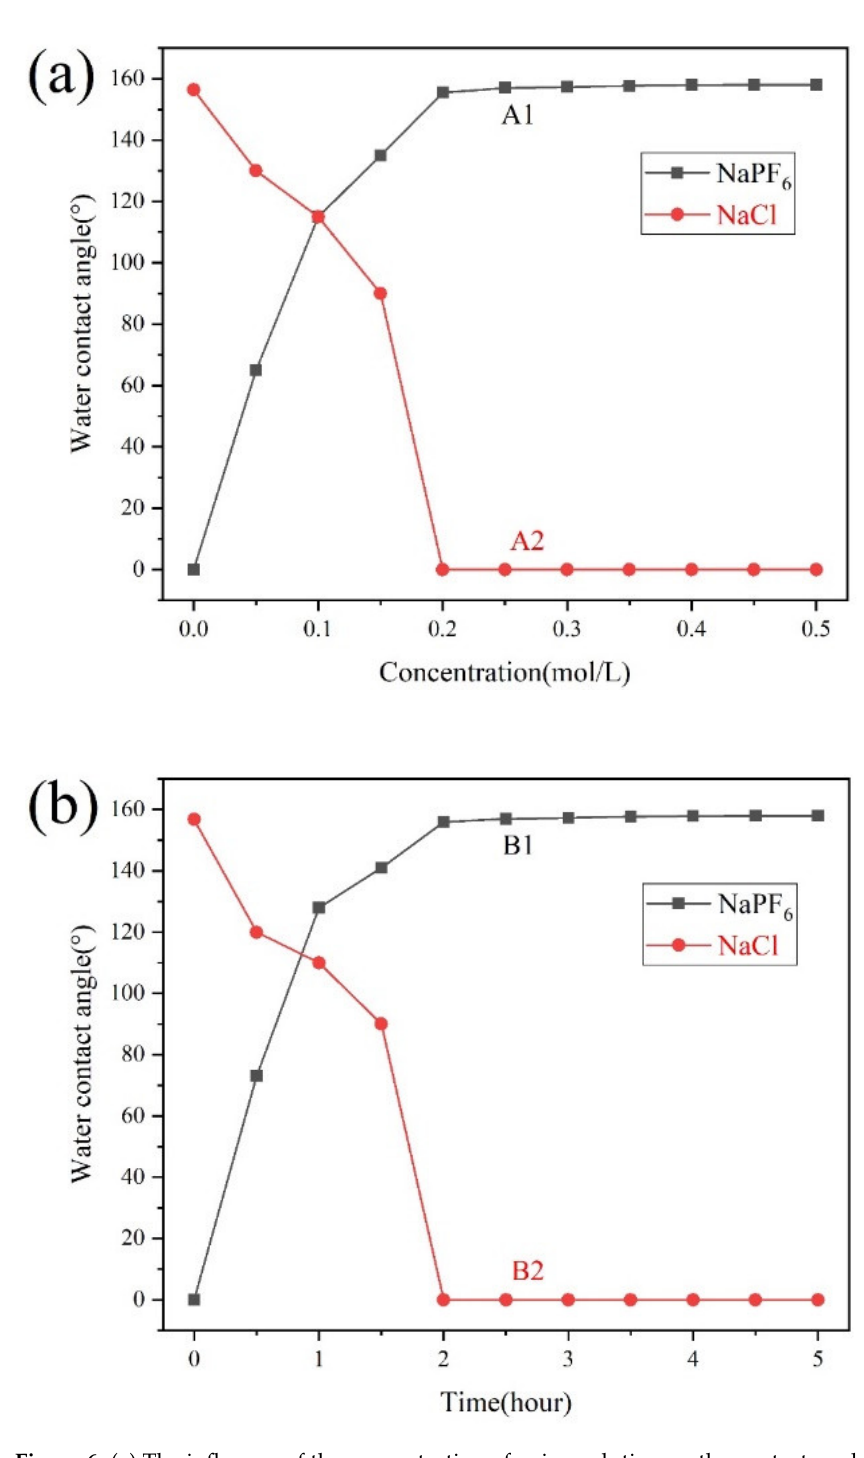
Figure 6. ( a ) The influence of the concentration of anion solution on the contact angle of the paper (soaking time is 2 h); ( b ) the effect of soaking time on the contact angle of the paper surface (the selected anion solution concentration is 0.2 mol/L).